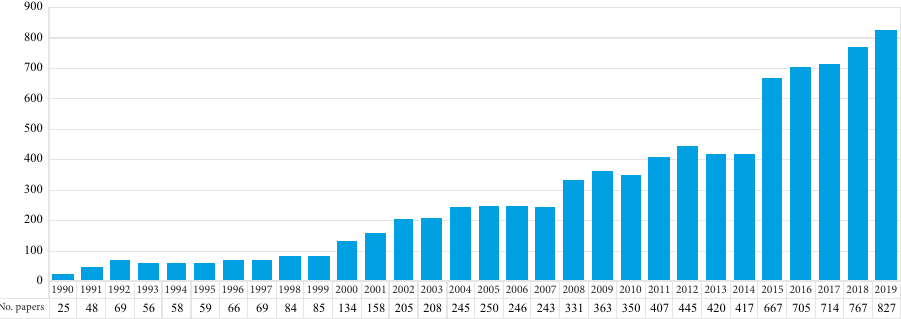
Figure 1. Publication trend over the